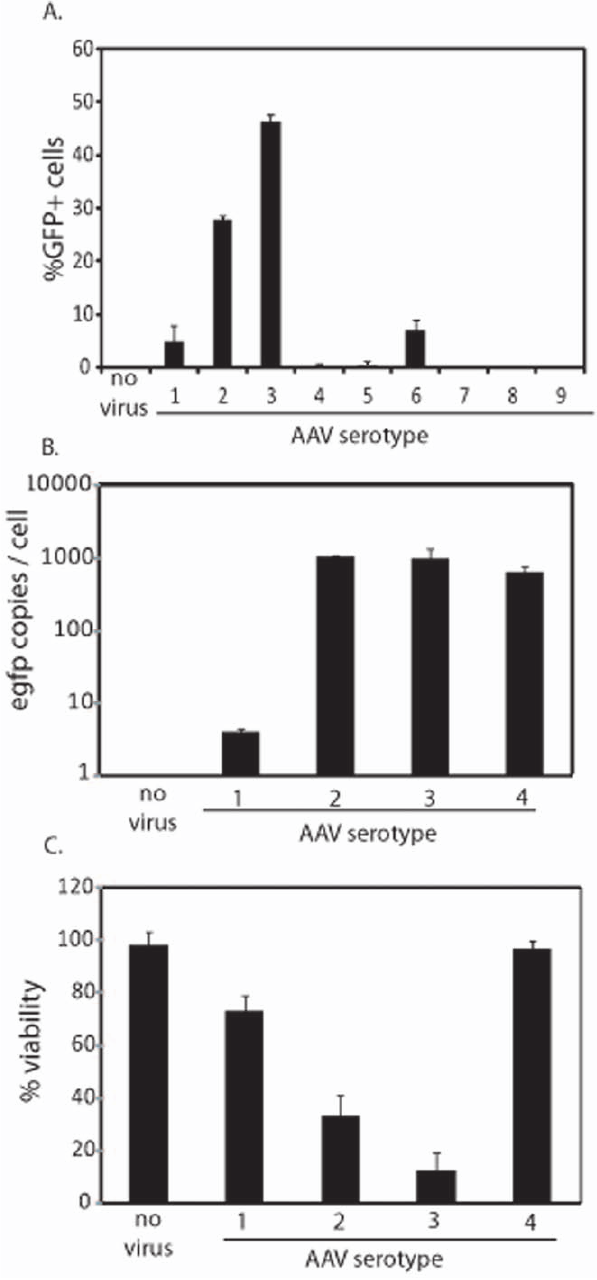
Figure 1. Recombinant AAV Transduction of hESCs. The indicated AAV serotypes were packaged with a self-complementary CMV- egfp genome and used to infect human embryonic stem cells (hESCs) at 100,000 viral genomes per cell. 24 h post-infection (post- infection) cells were harvested and GFP + cells were quantitated by flow cytometry (A.). Treated cells were also analyzed for intracellular transgene copy number normalized to the lamin B gene (B). Cell viability was also measured under the indicated conditions via dye exclusion (C) and significant decreases (p-value , 0.05) were noted in all cases (compared to no virus) except with AAV4 treatment (p- value=0.44). The results are averaged from at least 6 replicates for each treatment group and the standard deviation is